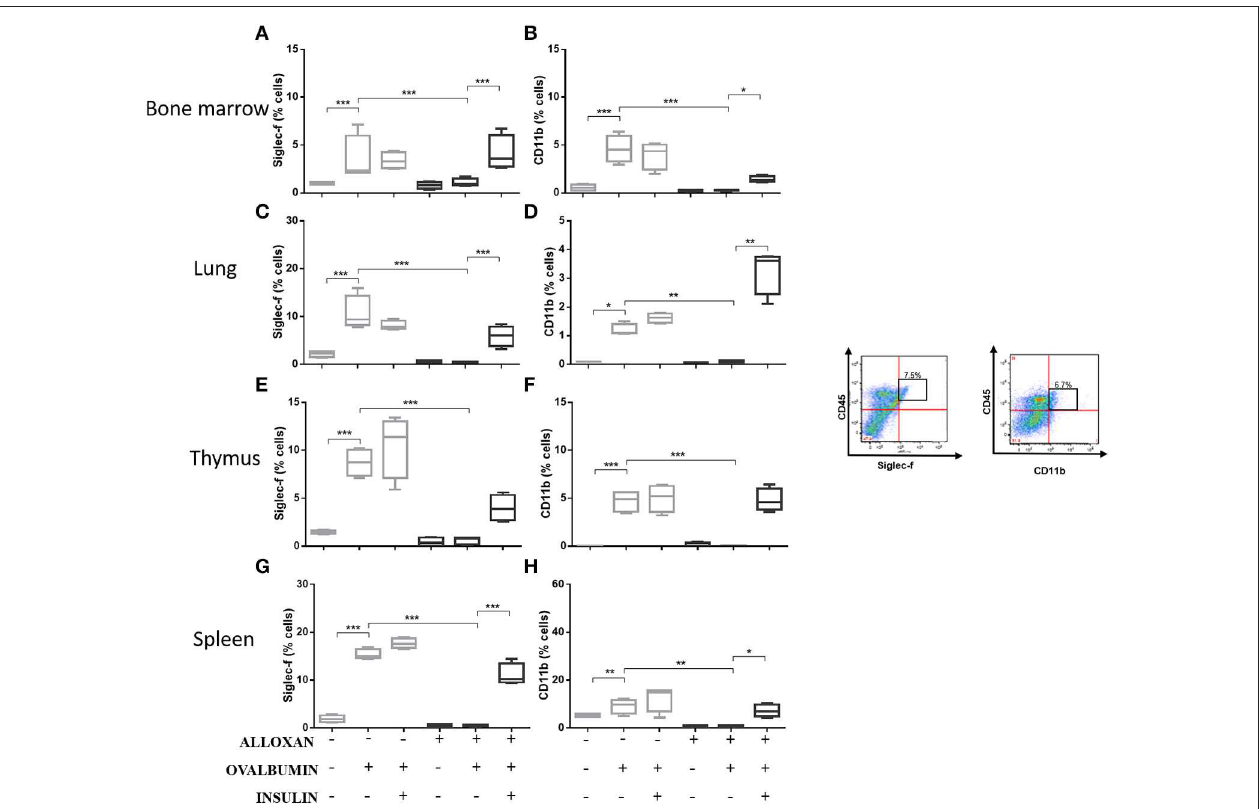
FIGURE 6 | Profile analysis of recruited eosinophils. Acquisitions were performed using an FACSCanto flow cytometer, and the data were analyzed using FlowJo software (Tree Star, Inc., USA). We analyzed 20,000 events. Representative dot plots showing the gating strategy used to identify eosinophils in the bone marrow, (A) Siglec-f and (B) CD11b; lung, (C) Siglec-f and (D) CD11b; thymus, (E) Siglec-f and (F) CD11b; and spleen, (G) Siglec-f and (H) CD11b. Values represent the mean ± SEM from three independent experiments ( n = 3 per group). * p < 0.05; ** p < 0.01; *** p < 0.001. The groups were tested with two-way analysis of variance followed by Tukey–Kramer post-hoc tests (GraphPad Prism version 6.0 for Windows, GraphPad Software, La Jolla, CA,